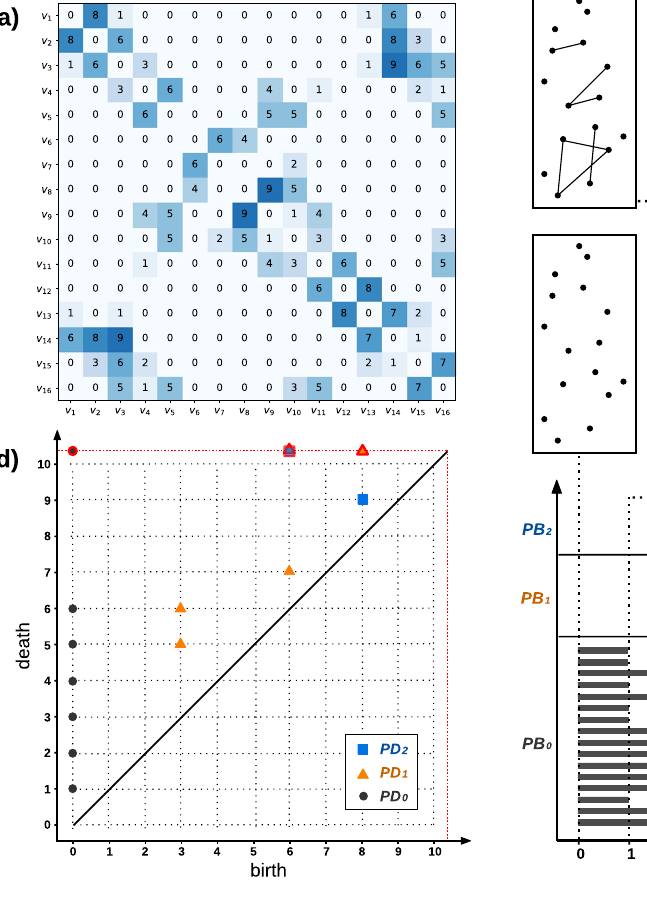
Figure 2. (a) An example of the adjacency matrix for a weighted network. The shade of each pixel corresponds to the weight of the link between the associated nodes. (b) A filtration for the weighted clique simplicial complex constructed from the weighted network. (c) Persistence barcode representing the topological evolution of k -dimensional topological holes. Evolution (birth-weight and death-weight) of any k -holes in the filtration are represented by a horizontal bar ( k = 0, 1, 2 black, orange and blue bar, respectively), starting from its birth- weight and ending at its death-weight. The arrows indicate the survived holes. (d) Persistence diagram for the filtration. Any k -hole in the filtration is shown by a point ( k = 0, 1, 2 black circle, orange triangle, and blue square, respectively), called persistence pair, in 2-dimensional Euclidean space, known as birth-death space. The first and the second element of the persistence pair equals birth-weight and death weight, respectively. The survived holes lie on the horizontal red